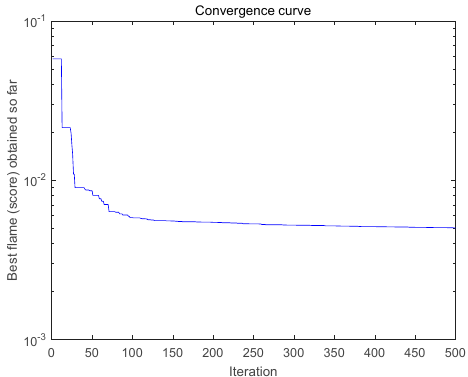
Figure 11. The convergence curve of the moth–flame optimization (MFO).